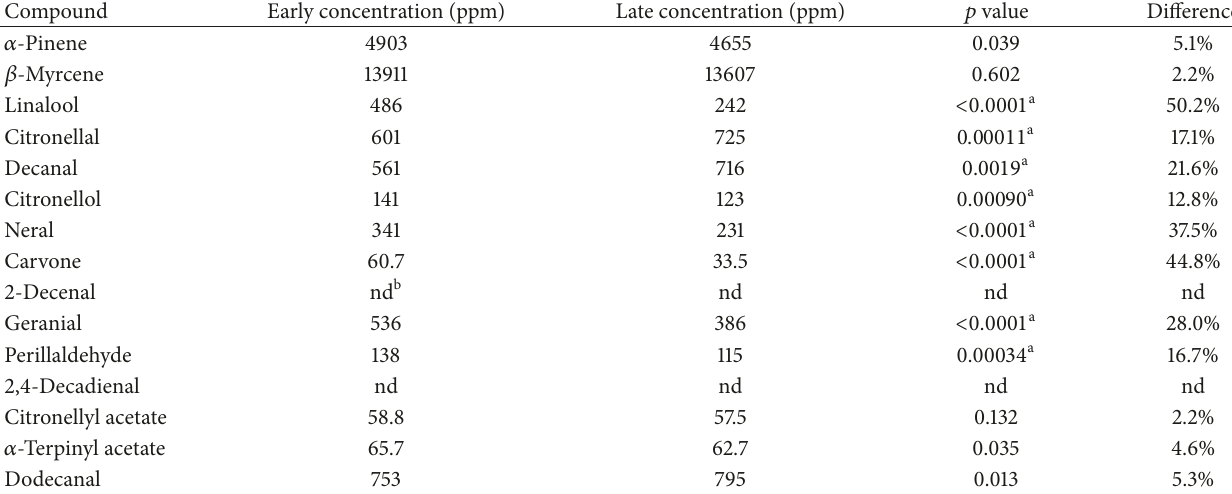
Table 8: Hamlin symptomatic early versus late compound